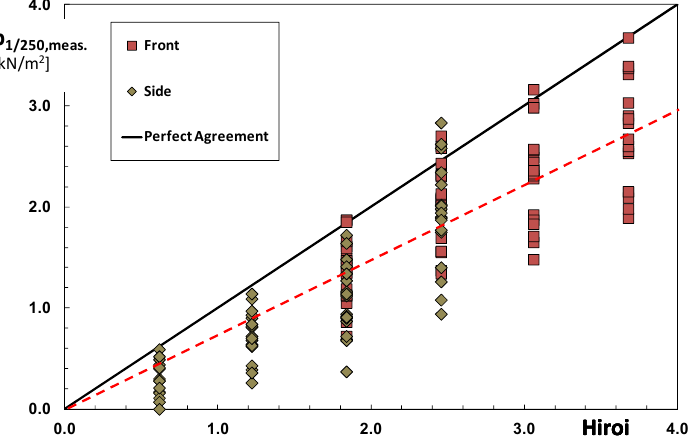
Figure 16. Measured wave pressures vs. predictions of the Hiroi